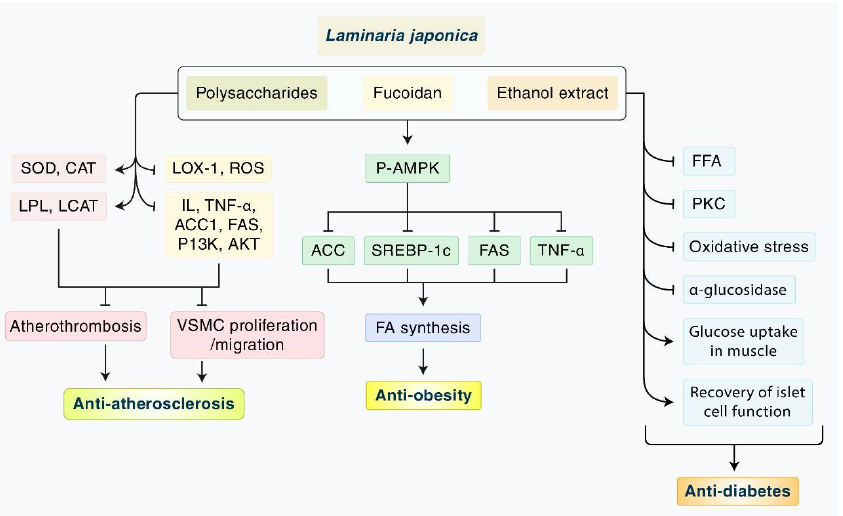
Figure 5. A schematic overview of the main mechanisms of LJP against atherosclerosis, obesity, and diabetes . LJP inhibits atherothrombosis by interrupting oxidative stress-related lipid peroxida- tion, the PI3K/Akt signaling pathway, inflammatory and macrophage-related cytokines, and the proliferation and migration of VSMC. LPJ exhibits the anti-obesity effect through the upregulation of P-AMPK. Subsequently, it inhibits ACC, SREBP-1c, and TNF-α, which results in decreased FA synthesis. LJP has the potential to play a role as the antidiabetic agent through the inhibition of the mobilization of FFA, PKC, oxidative stress, and α-glucosidases. LJP may increase glucose uptake and responsiveness to insulin in the muscle and recover the pancreatic islet cell secreting function, resulting in the regulation of blood sugar level and insulin resistance. ACC1: acetyl-CoA carbox- ylase; CAT: catalase; FFA: free fatty acids; IL: interleukin; LCAT: lecithin cholesterol acyltransferase;